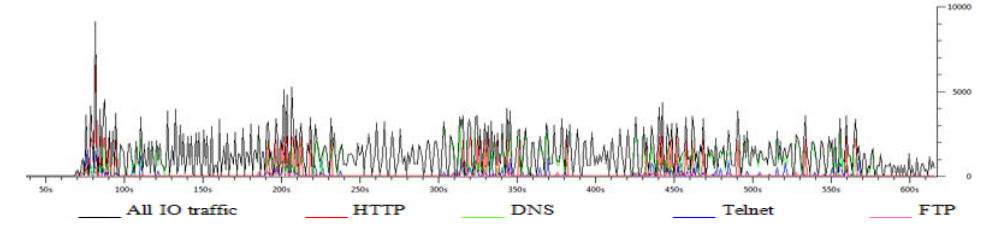
Fig.8. Detected services and version of low interaction honeypots through high interaction honeypot